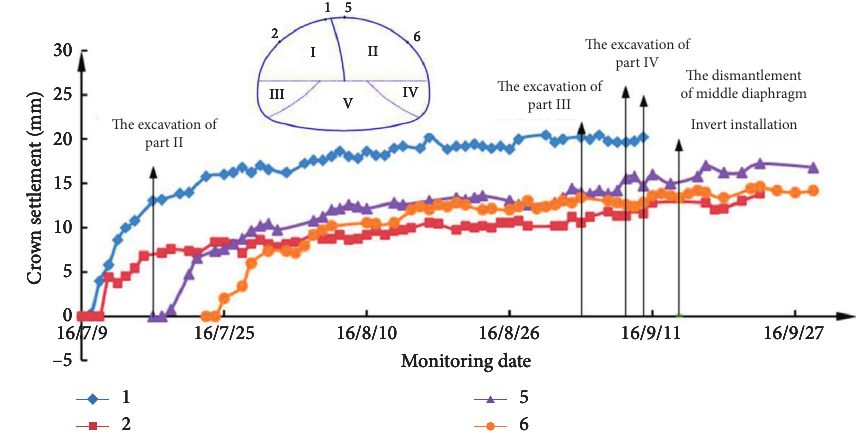
Figure 10: Temporal diagram of crown